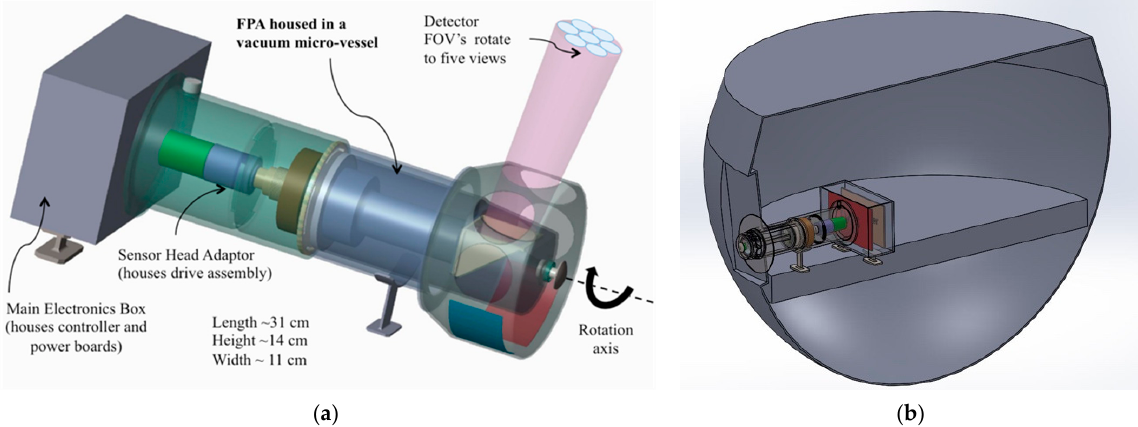
Figure 1. ( a ) Mechanical drawing of the IG-NFR instrument concept; ( b ) IG-NFR accommodated inside the probe.